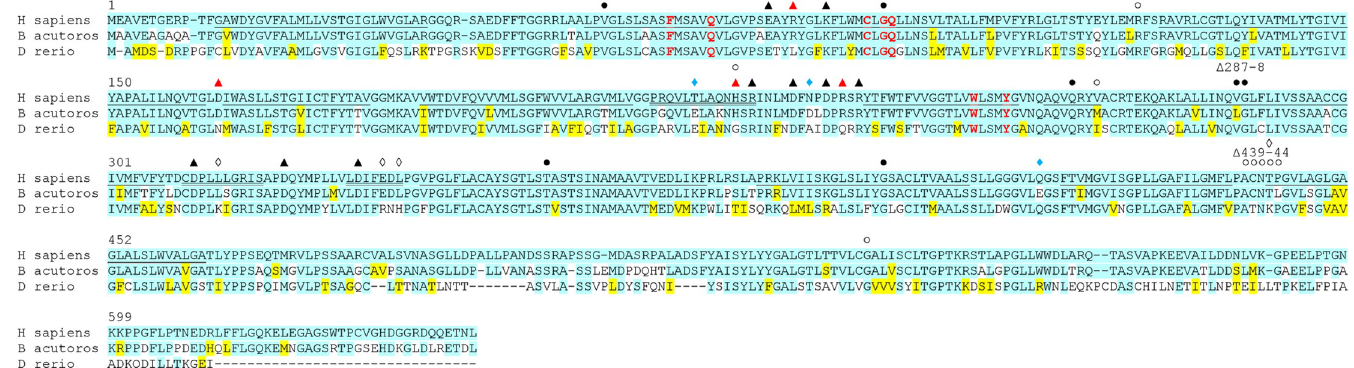
Fig 1. Amino acid sequence alignment between the NIS proteins of H . sapiens (human), B . acutorostrata scammoni (minke whale), and D . rerio (zebrafish). Cyan highlighting indicates absolute conservation to human NIS. Yellow indicates similar residue to human NIS. Underline indicates putative transmembrane domain in human NIS, only TM1-12 are indicated. Closed circles indicate site of a mutation known to cause a transport defect in humans [22]. Open circles indicate site of a mutation known to cause membrane trafficking defect in humans [22]. Black triangles indicate a charged residue where mutation to alanine significantly reduces iodide uptake in human NIS [71]. Red triangles indicate a charged residue where mutation to alanine significantly reduces iodide uptake in human NIS and this residue is not charged in zebrafish NIS [71]. Open diamonds indicate additional positively charged residues in zebrafish NIS. Blue diamonds indicate additional negatively charged residues in minke whale NIS. Bold red lettering indicates residue reported to be involved in stoichiometry control and translocation dynamics [52–53]. Numbering follows human NIS.